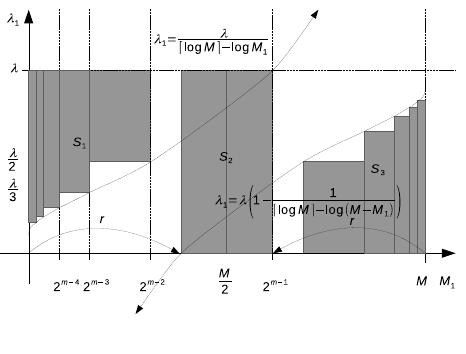
Fig. 4. In the case of 0 (cid:54) r < 2 m − 2